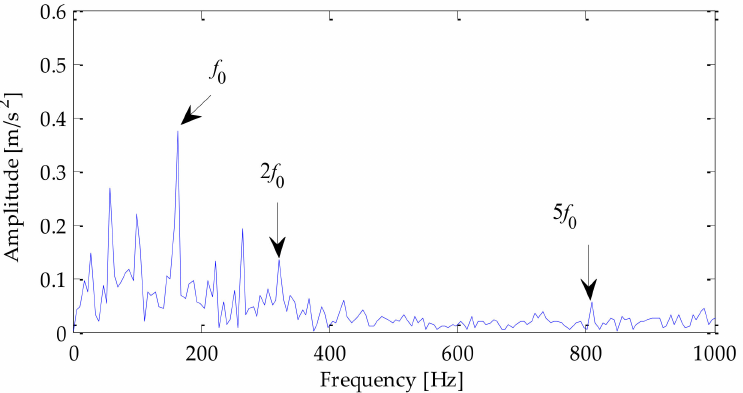
Figure 29. Analysis of signal envelope spectrum after noise reduction based on the proposed